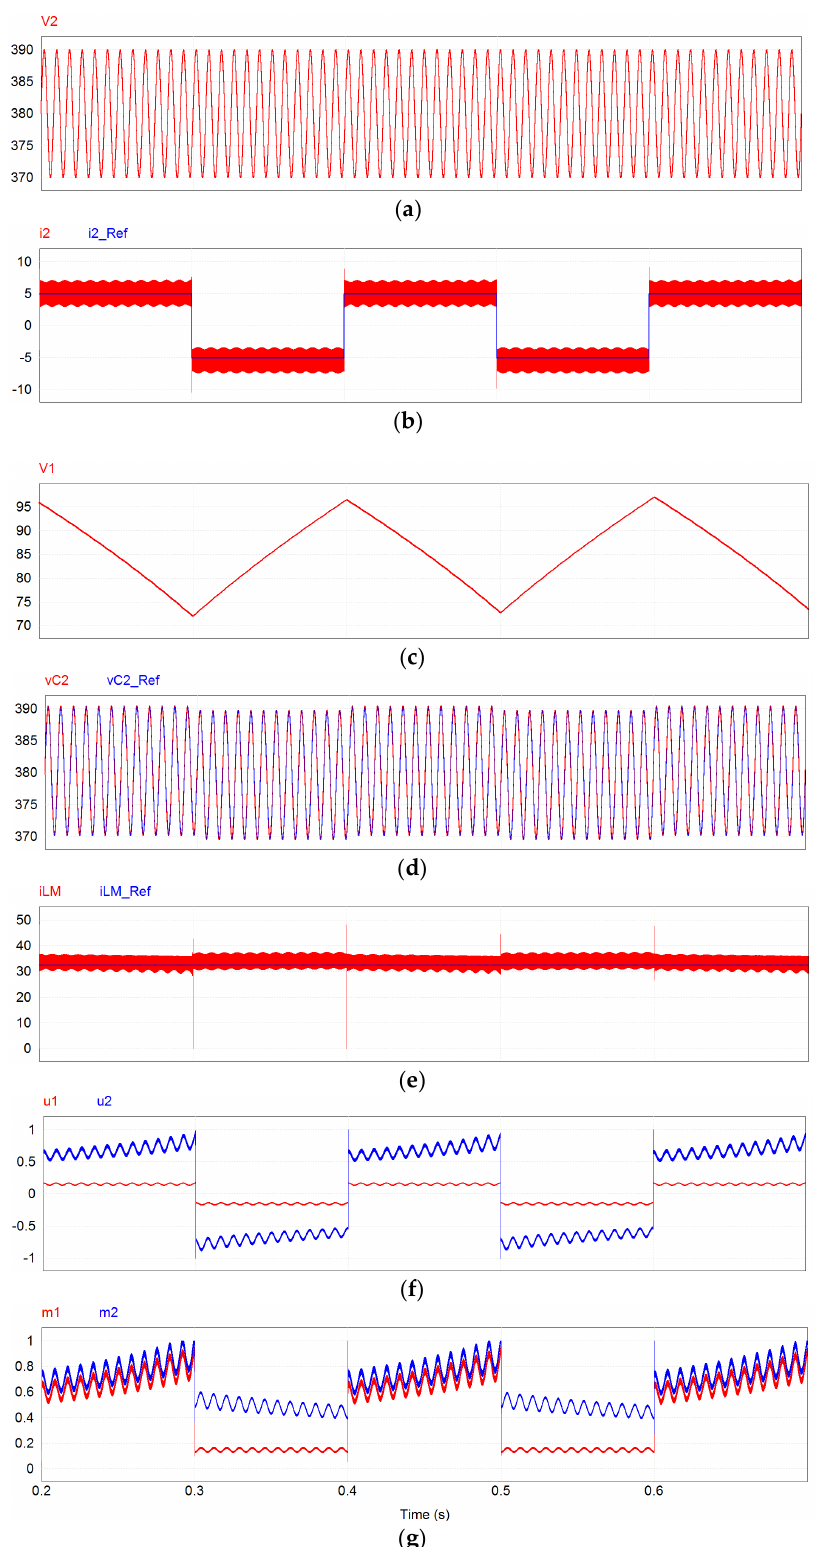
Figure 14. Waveforms for the tri-state buck – boost control with state feedback linearization for test 2. ( a ) Voltage at Bus 2 (in V), ( b ) reference and output current (in A), ( c ) voltage at Bus 1 (in V), ( d ) reference and output capacitor voltage (in V), ( e ) reference and inductor current (in A), ( f ) non-linear control variables, ( g ) PWM modulation signals.